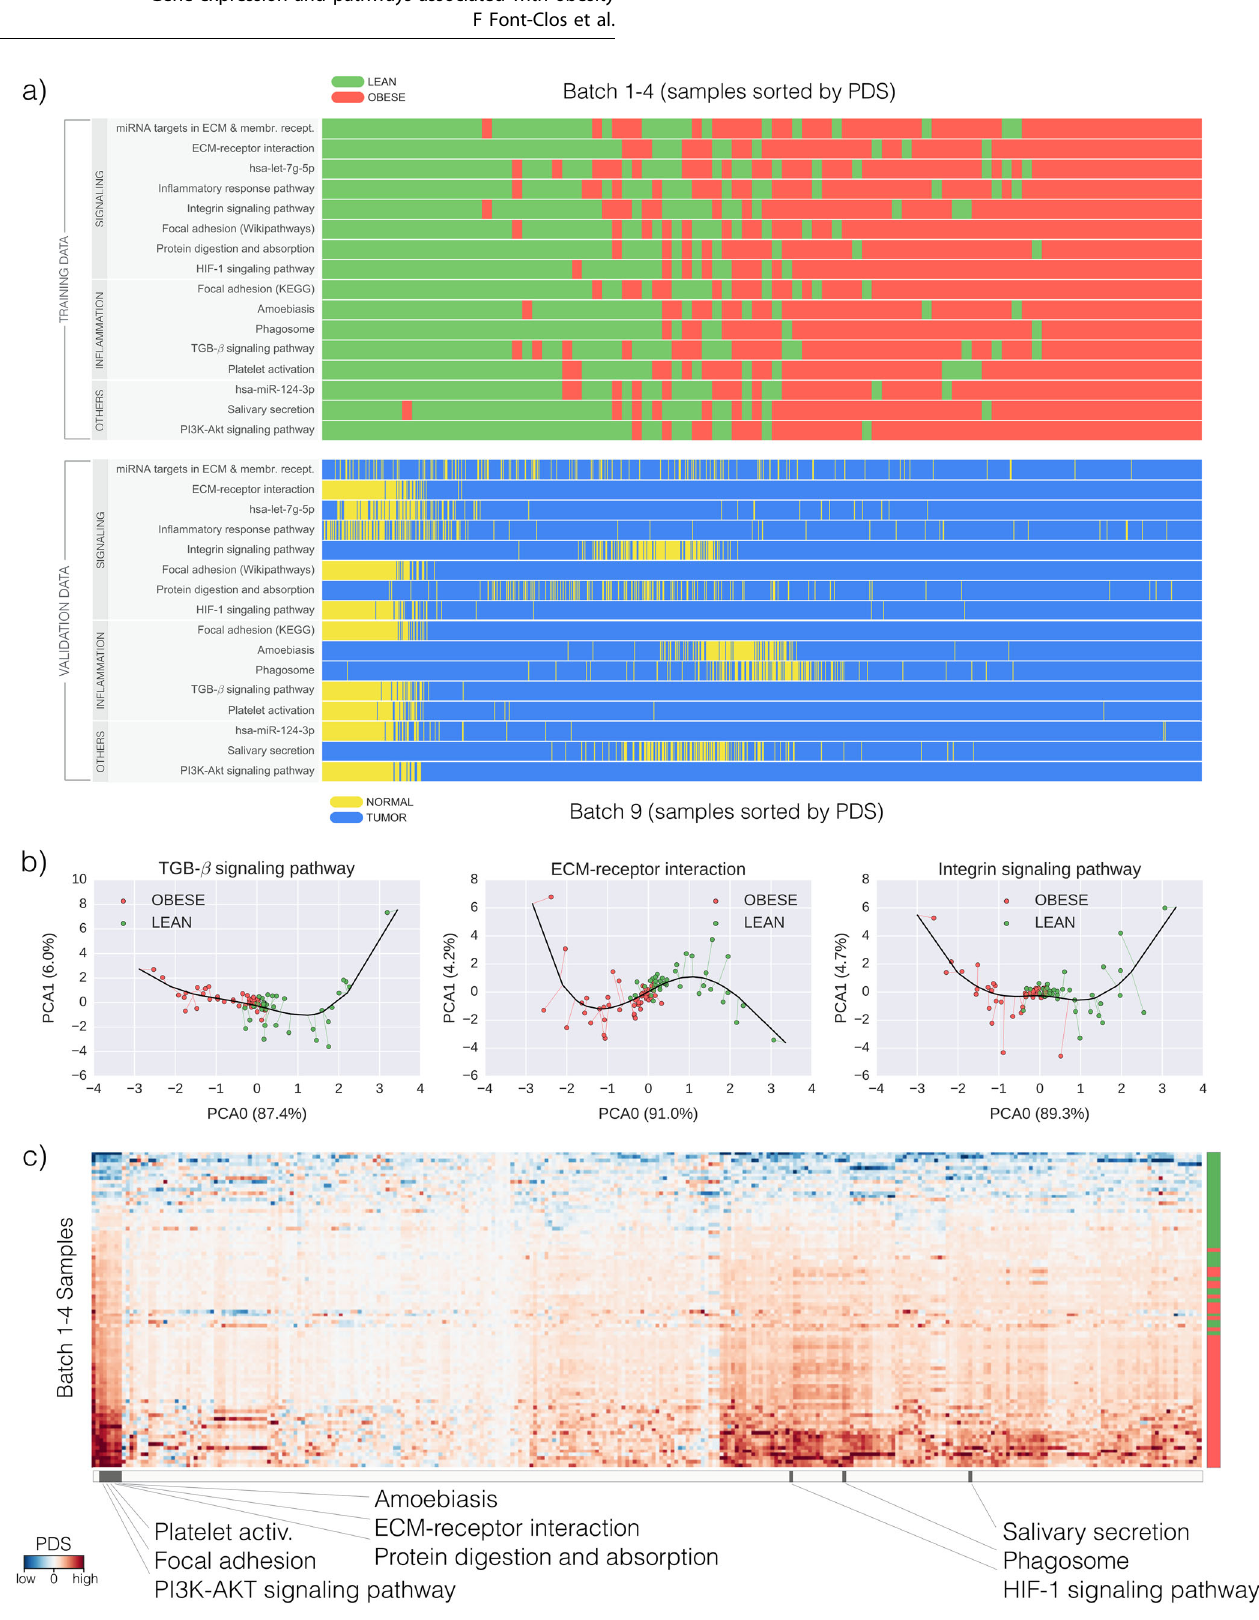
linked to the gender of the subjects. The robustness of the signature has been con fi rmed on four independent data